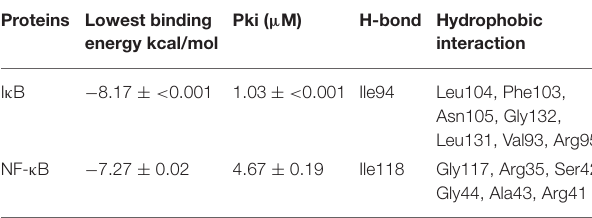
TABLE 4 | Molecular docking of sanguinarine to I κ B and NF- κ B proteins. Proteins Lowest binding Pki ( µ energy kcal/mol